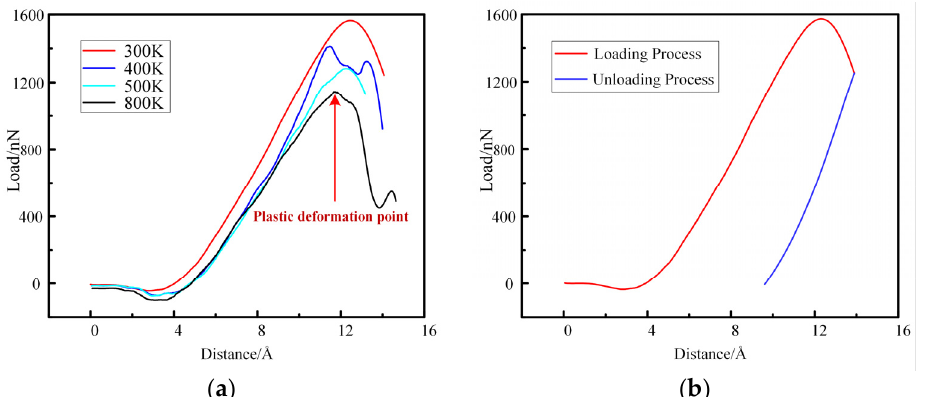
Figure 8. ( a ) Load-Distance curves of M50 bearing steel simulated by nanoindentation at different temperatures; ( b ) Load-Distance curve of M50 bearing steel simulated by nanoindentation during loading and unloading process at 300 K.